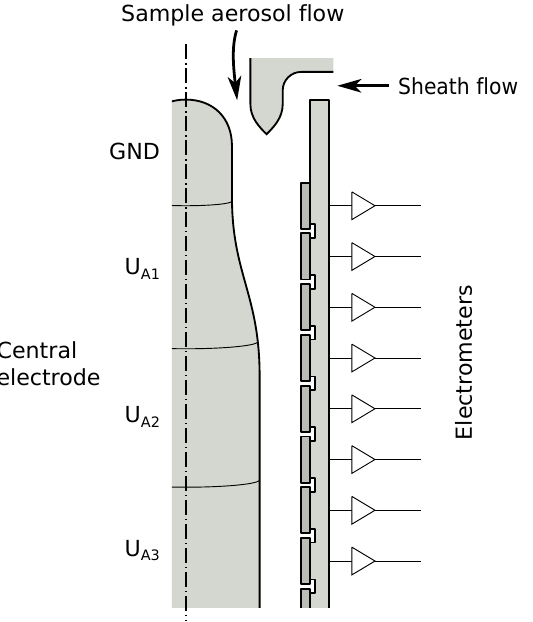
Fig. 4. Schematic of NAIS mobility analyzer.